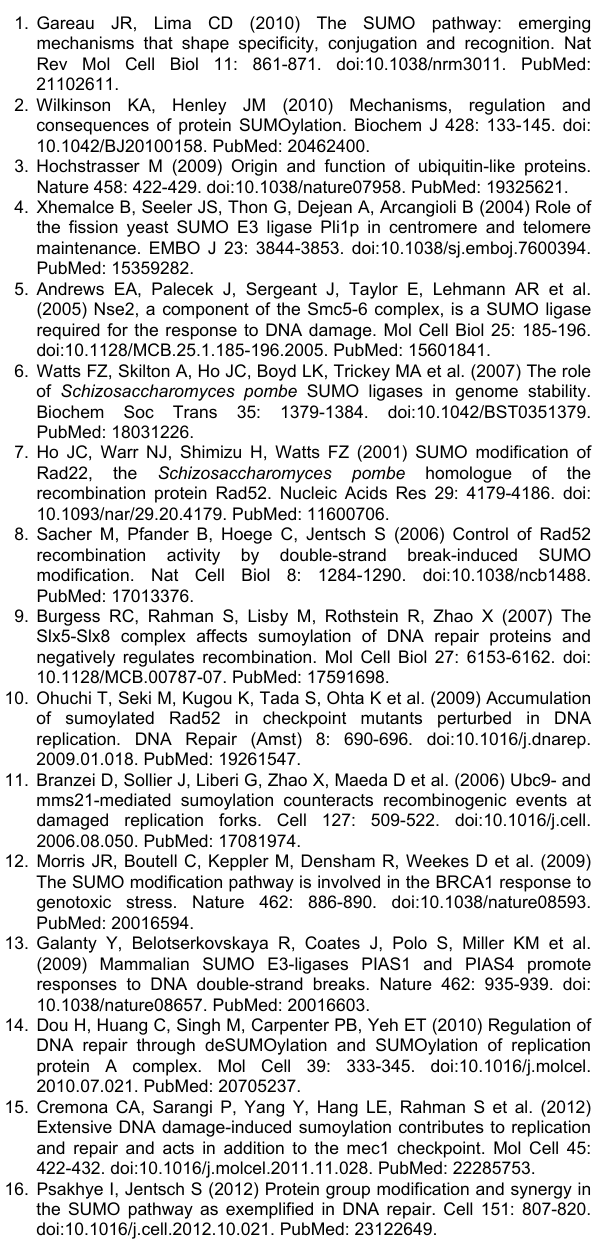
Table S2. Number of Rad22-YFP foci and nuclei counted to produce the bar graphs shown in Figure 4C. Numbers were combined from three independent